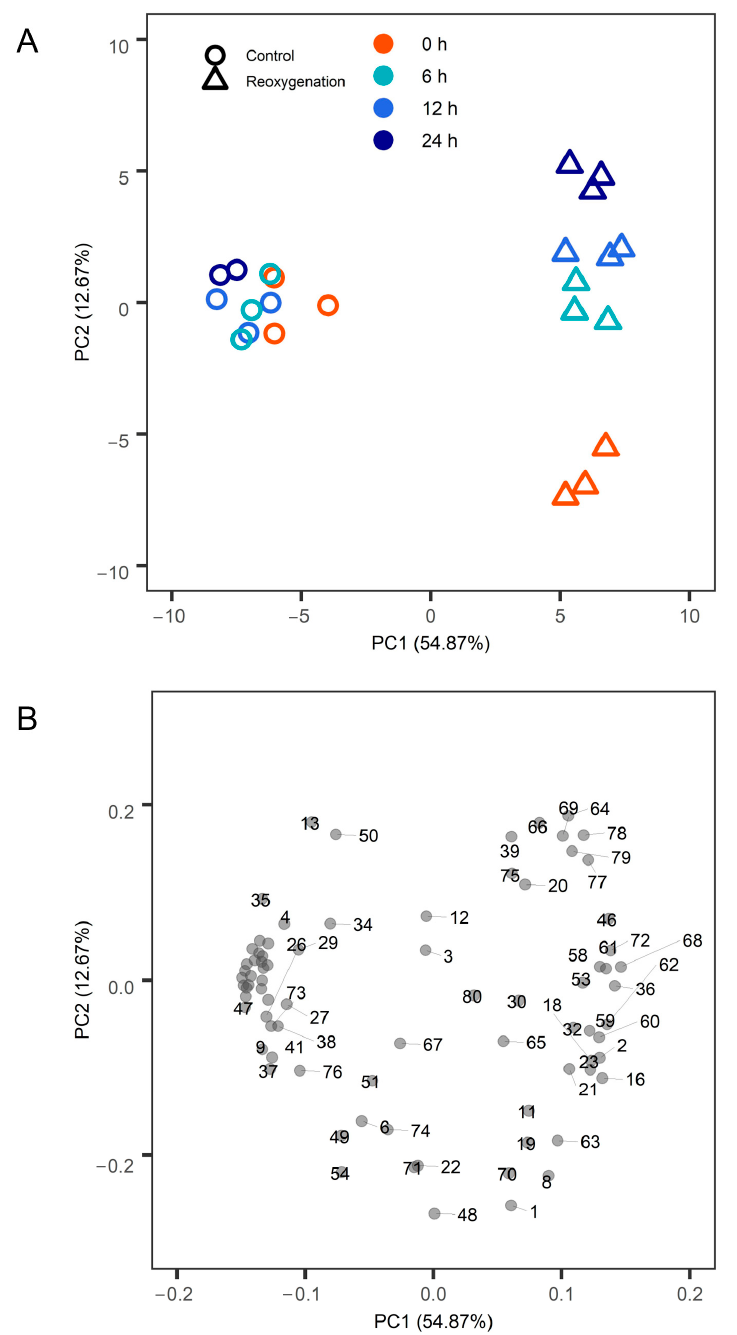
Figure 2. Principal component analysis (PCA) of metabolic profiles of Arabidopsis seedlings in response to hypoxia stress and subsequent reoxygenation recovery. ( A ) The score plot of PCA. Samples under hypoxia treatment and recovery are shown in triangles, and control samples grown in the chamber filled with air are shown in circles. Time points are indicated by different colors. ( B ) The PCA loading plot.